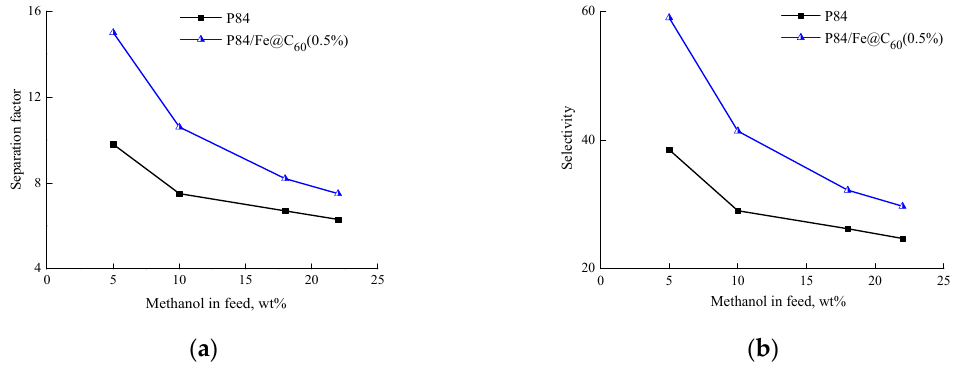
Figure 7. Dependence of ( a ) separation factor α MeOH/MeOAc and ( b ) selectivity β MeOH/MeOAc on methanol concentration in the feed for the pervaporation of the methanol—methyl acetate mixture through the P84 and P84/Fe@C 60 (0.5%) membranes, 25 ° С .